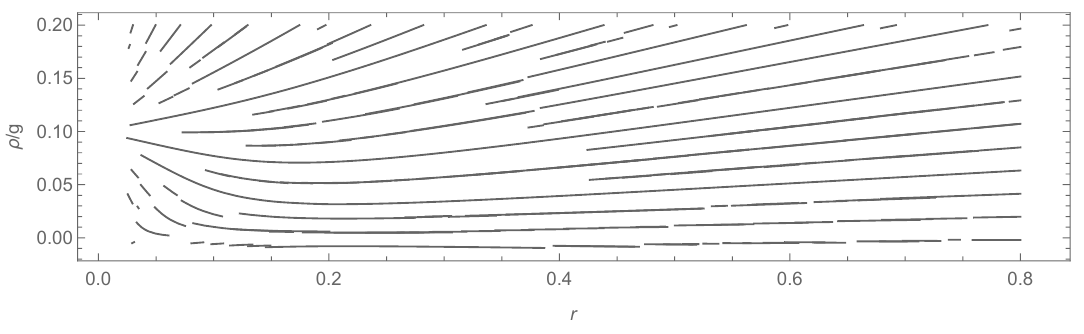
Figure 3 . Force lines (gradient flows) of a Type II